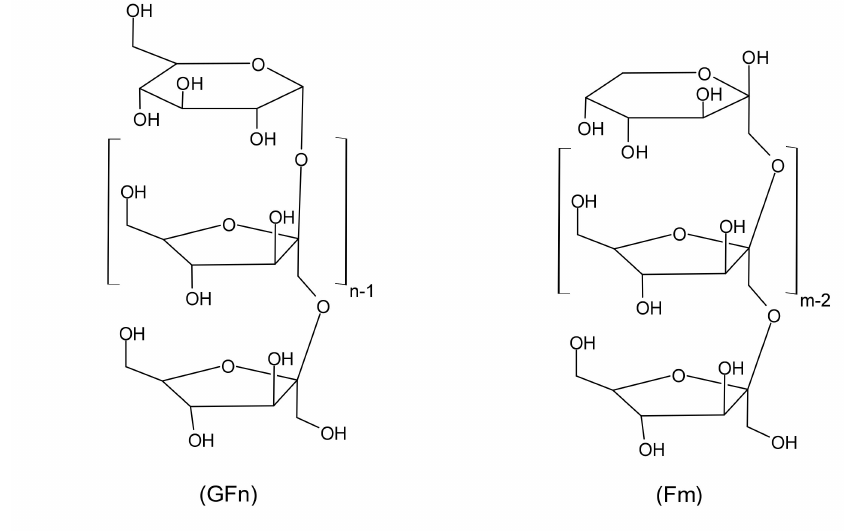
Figure 1. Structure of